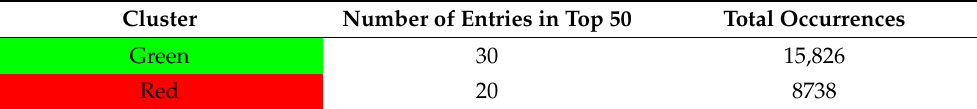
Table 7. Overview cluster distribution of top 50 keywords according to occurrences.